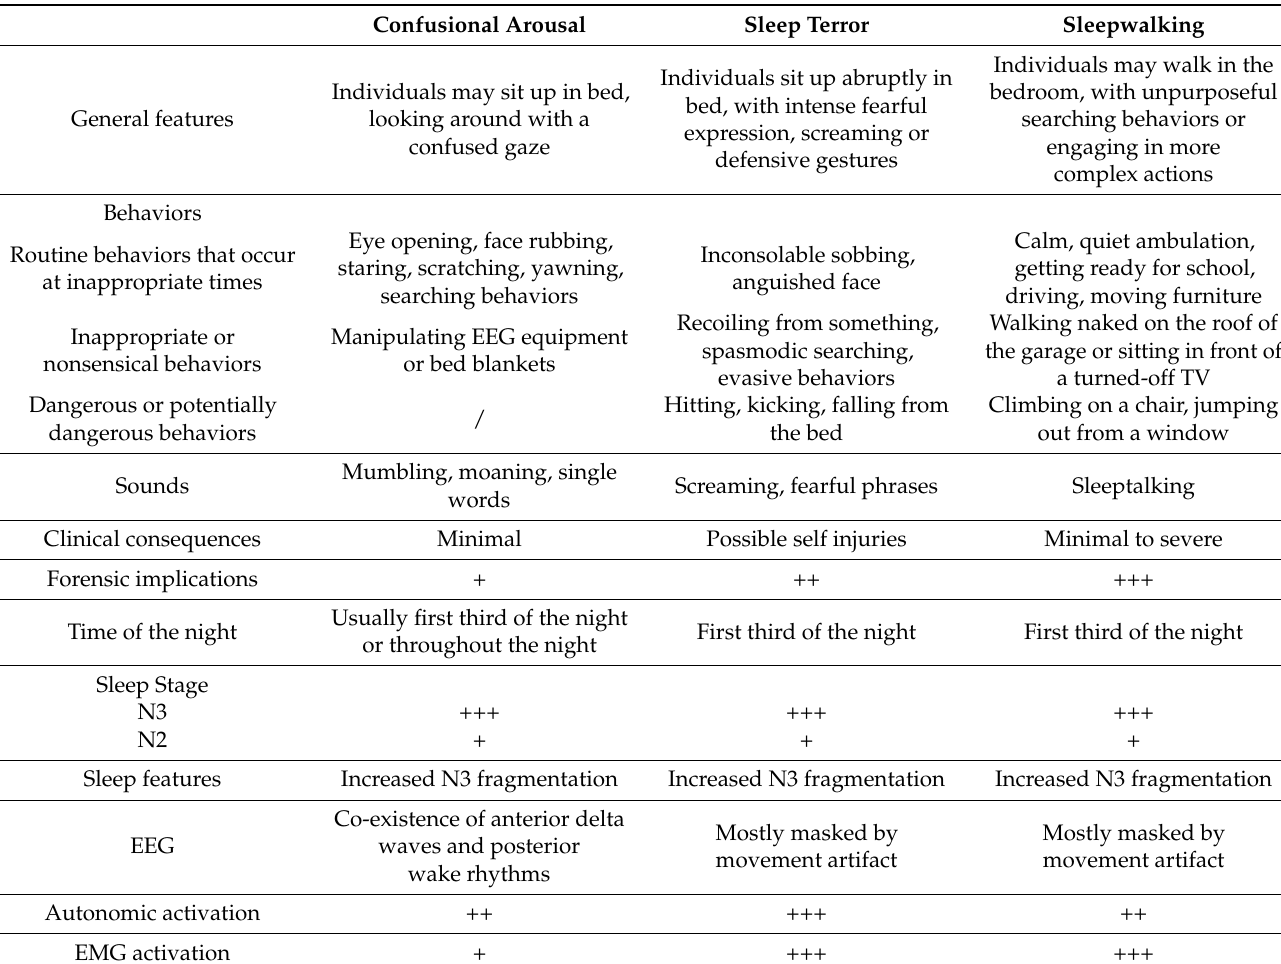
Table 1. Clinical and sleep-related features of the different DoA